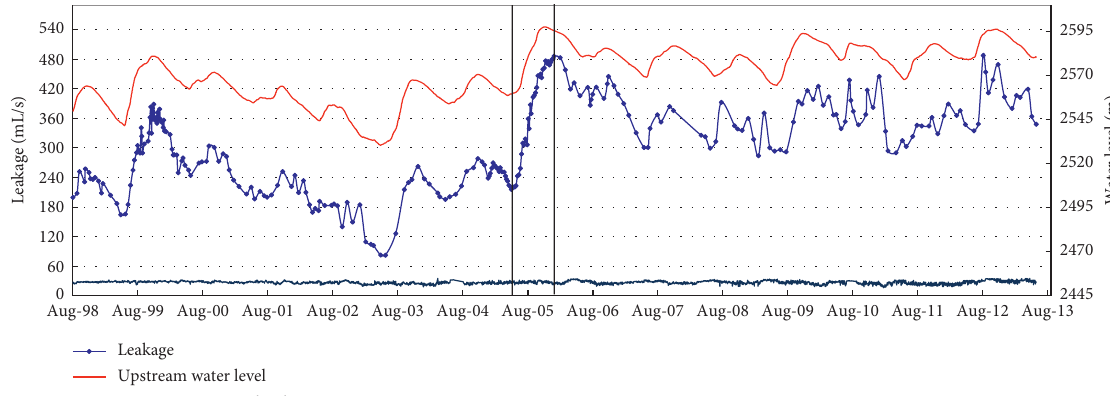
Figure 11: Measured time series of the leakage at 2463m elevation of the F